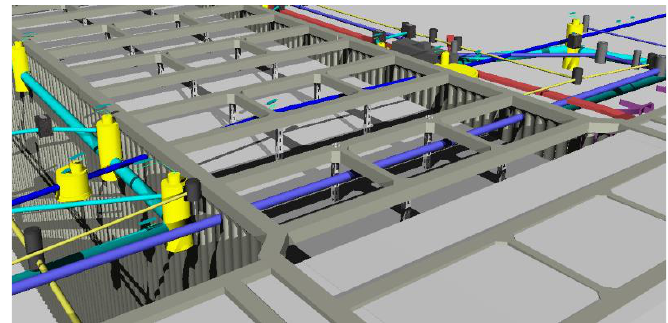
Figure 3. Schematic diagram of the excavation support system.